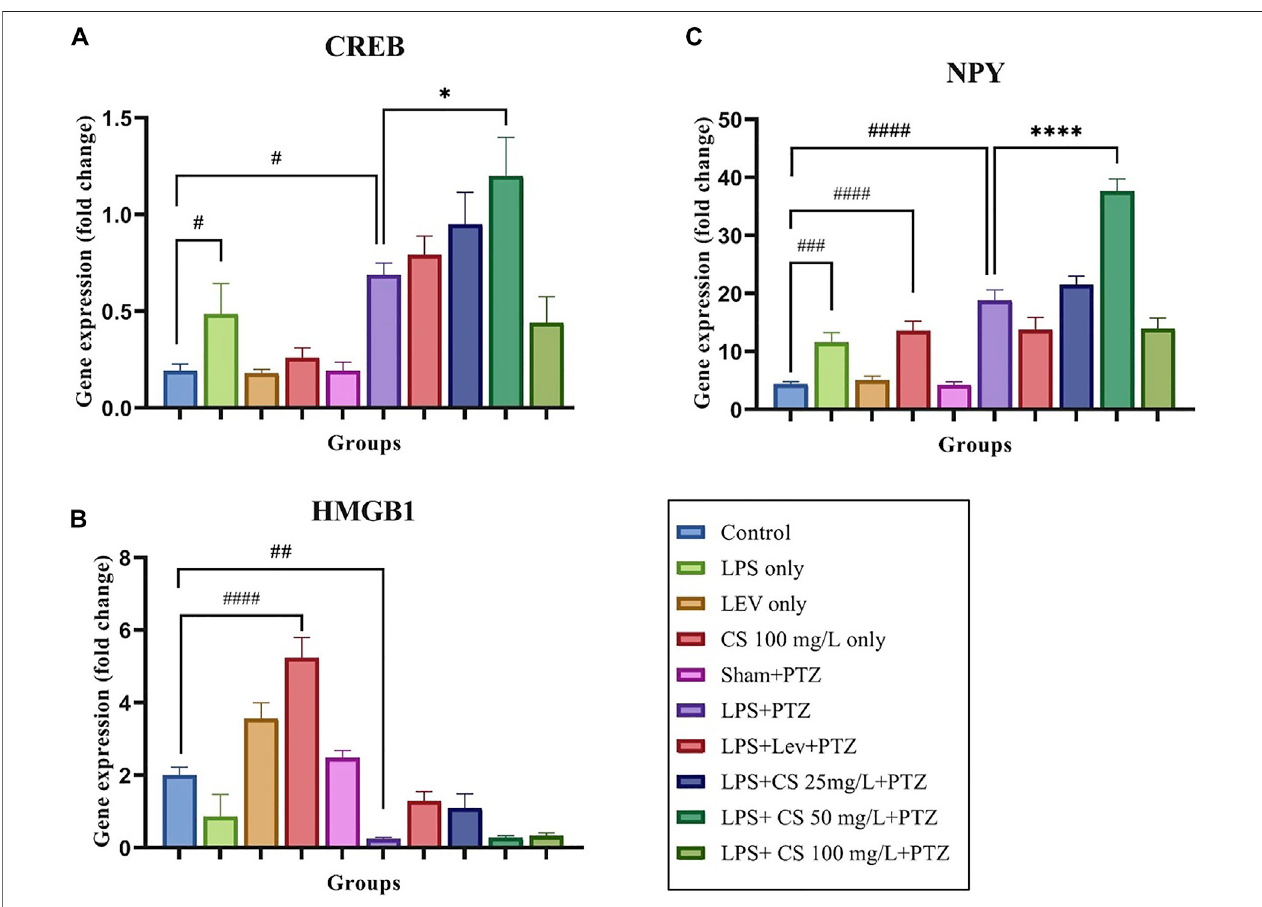
FIGURE 3 | Gene expression levels for the following genes: (A) CREB, (B) NPY, and (C) HMGB1. The p -values **** p < 0.0001, *** p < 0.001, ** p < 0.01, and * p < 0.05 were regarded as statistically signi fi cant for the treatment groups compared to the negative control (LPS + PTZ). The p -values #### p < 0.0001, ### p < 0.001, ## p < 0.01 and # p < 0.05 was regarded as statistically signi fi cant for the per se groups compared to the control.